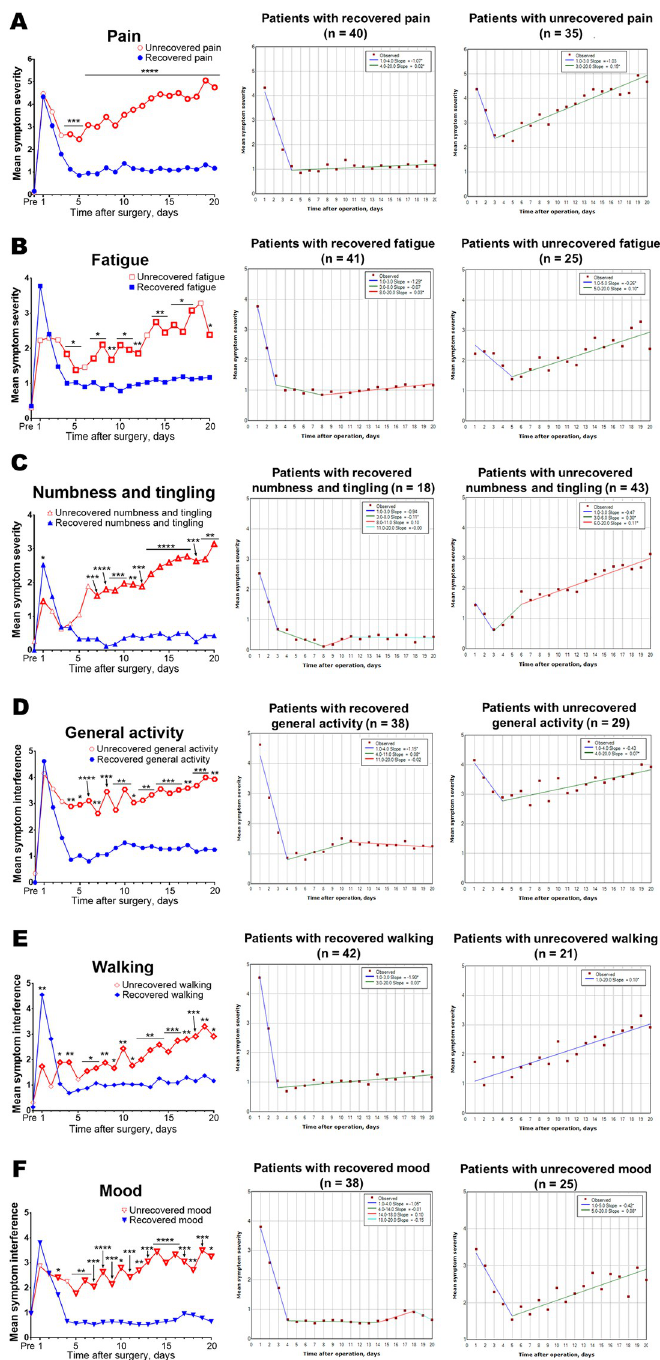
Fig 3. Symptom severity trajectories and the models using the joinpoint regression analysis for patients with recovered or unrecovered symptom at the first post-discharge clinic visit. A: Patients with unrecovered pain had been experiencing more severe pain than those with recovered pain since day 4. Both, patients with recovered pain and those with unrecovered pain, showed a rebound in the severity trajectory. B: Patients with unrecovered fatigue tended to experience more severe fatigue than those with recovered fatigue following day 4. Both patients with recovered fatigue and those with unrecovered fatigue showed a rebound in the severity trajectory. C: Initially, numbness and tingling were more severe in patients with recovered numbness and tingling than those with unrecovered numbness and tingling. Following day 7, patients with unrecovered numbness and tingling experienced greater numbness and tingling than their counterparts. Only patients with unrecovered numbness and tingling showed a rebound in the